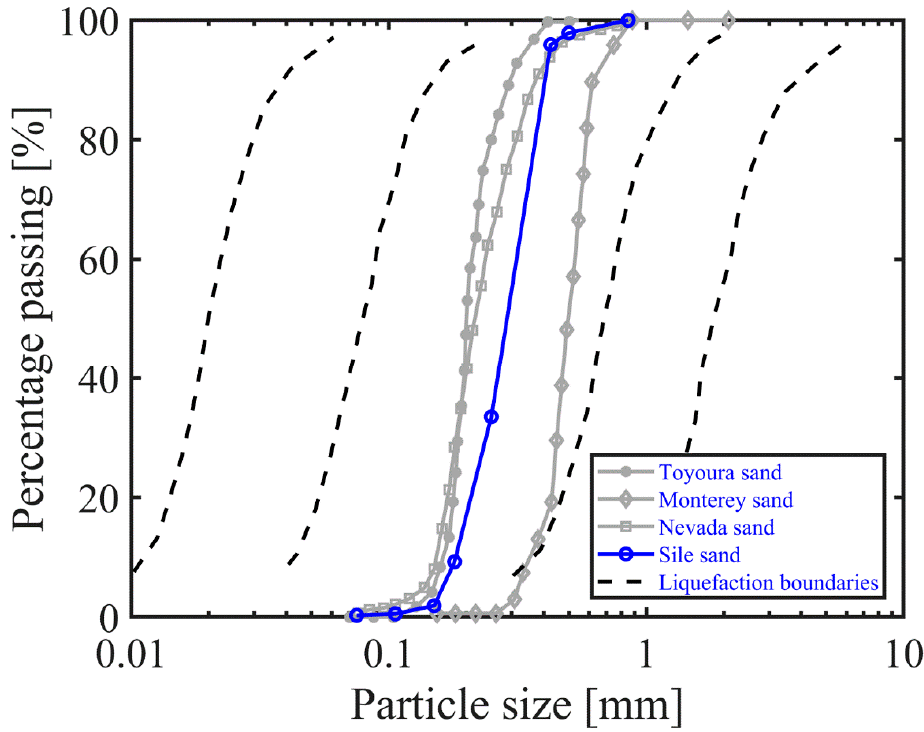
Figure 2. Particle size distribution curve for Sile sand and its comparison with different types of sand and liquefaction boundaries suggested by Tsuchida [52]. Table 1. The index properties of Sile sand.